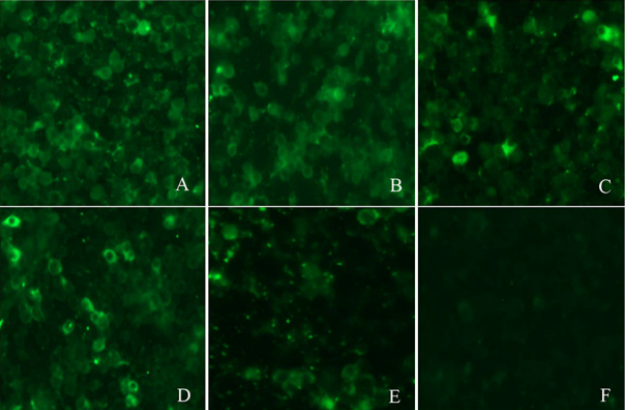
Figure 6. Reactivity of five positive sera with PPV antibodies by IFA. ( A – E ) are the IFA results of the five sera, respectively. ( F ) IFA analysis of SPF pig serum (negative control).